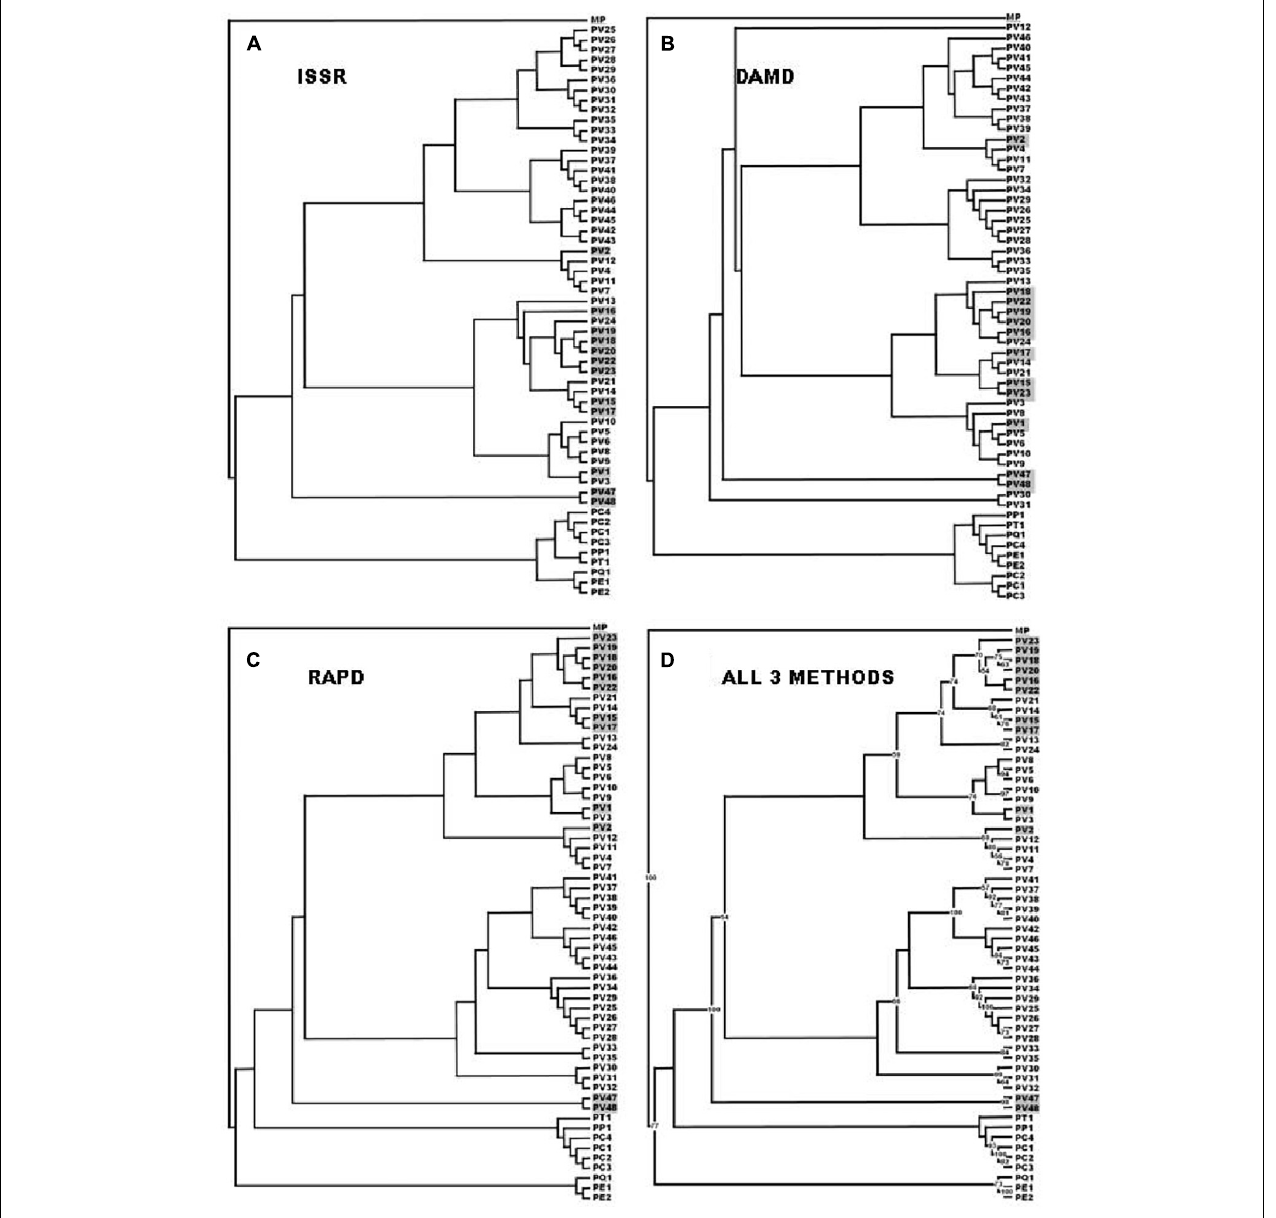
FIGURE 3 | The UPGMA dendrogram with 1000 replicate bootstrap analysis based on the Jaccard coefficient of similarity for all three SPAR methods (ISSR) were considered cumulatively. PV 1–PV 23: UP – Uttar Pradesh State except PV 3, that was from UKD - Uttarakhand State; PV 24 and PP 1: KER – Kerala State; PV 25–PV 26: MAH - Maharashtra State; PV 27– PV 29: TN – TamilNadu State; PV 30–PV 35: MEG - Meghalaya State; PV 36: SKM - Sikkim State; PV 37 and PV 39 PV 48: UP – Uttar Pradesh state; PV 38: MP – Madhya Pradesh State; PC 1–PC 4 and PE 2: UP – Uttar Pradesh State; PE 1: TN – TamilNadu State; PP 1: KER – Kerala State; PQ 1 and PT 1: TN – TamilNadu State. MP: Microsorum punctatum, used in the present study as an